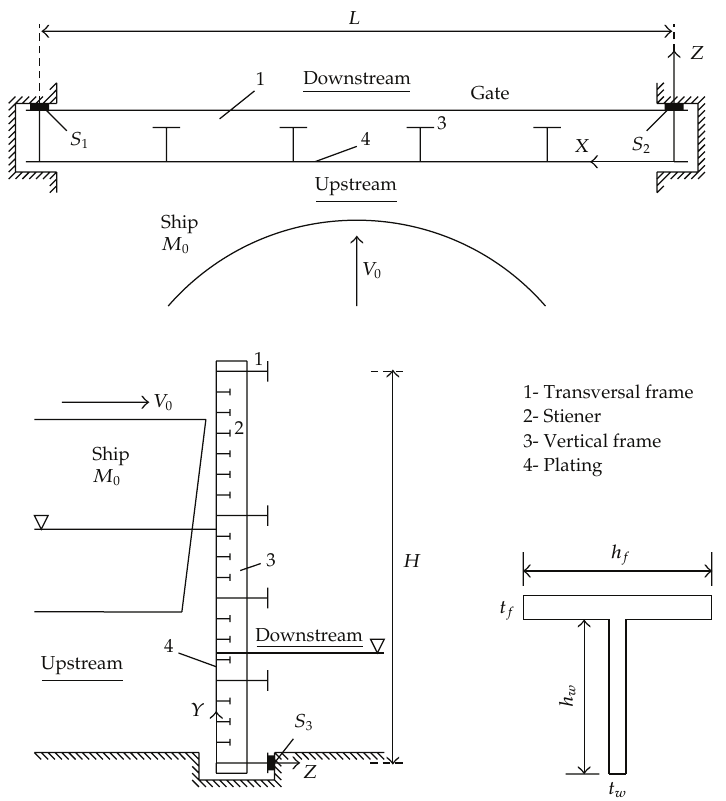
Figure 3: Plan and section views of the